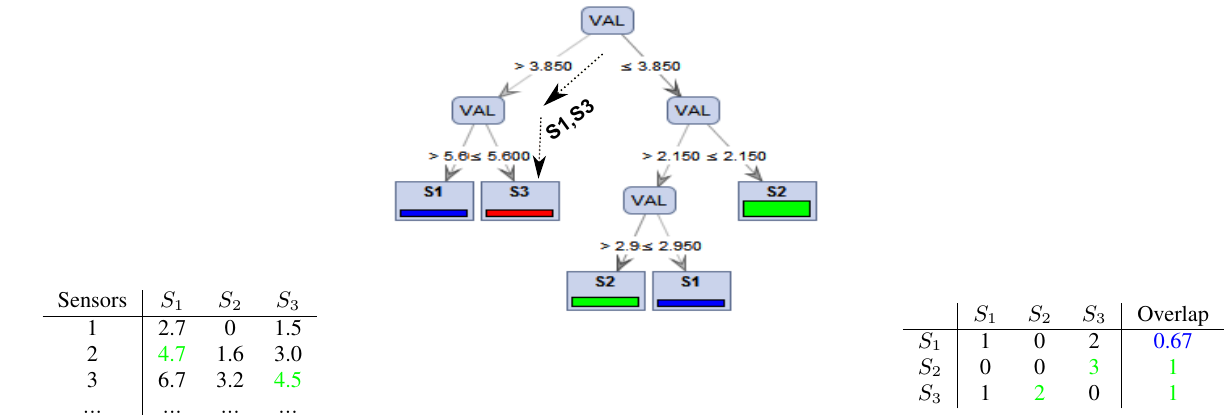
Fig. 3 S 1 & S 3 end up in the same terminal node. The Big-Table proximity count is incremented by 1. (The color metric in the overlap